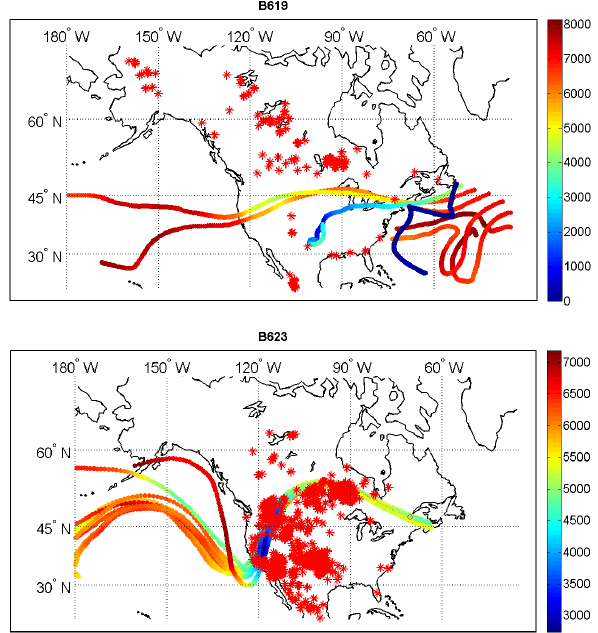
Figure 4. Location of the boreal biomass burning activity during the BORTAS campaign recorded by the FLAMBE inventory (red aster- isks) and air mass backward trajectory analysis starting from loca- tion along the flight trajectories. Flight B623 (lower panel) sampled multiple fire plumes, whereas flight B619 (upper panel) was repre- sentative of background